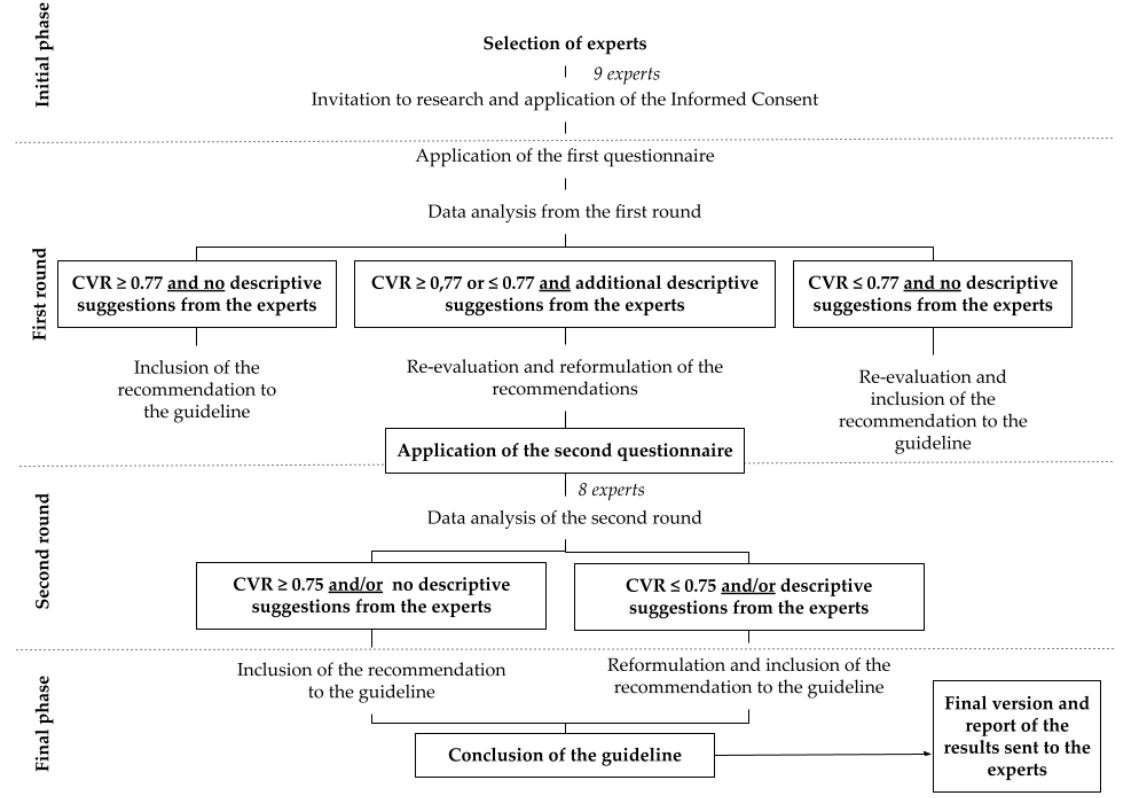
Figure 1. Process flowchart of the Delphi study.